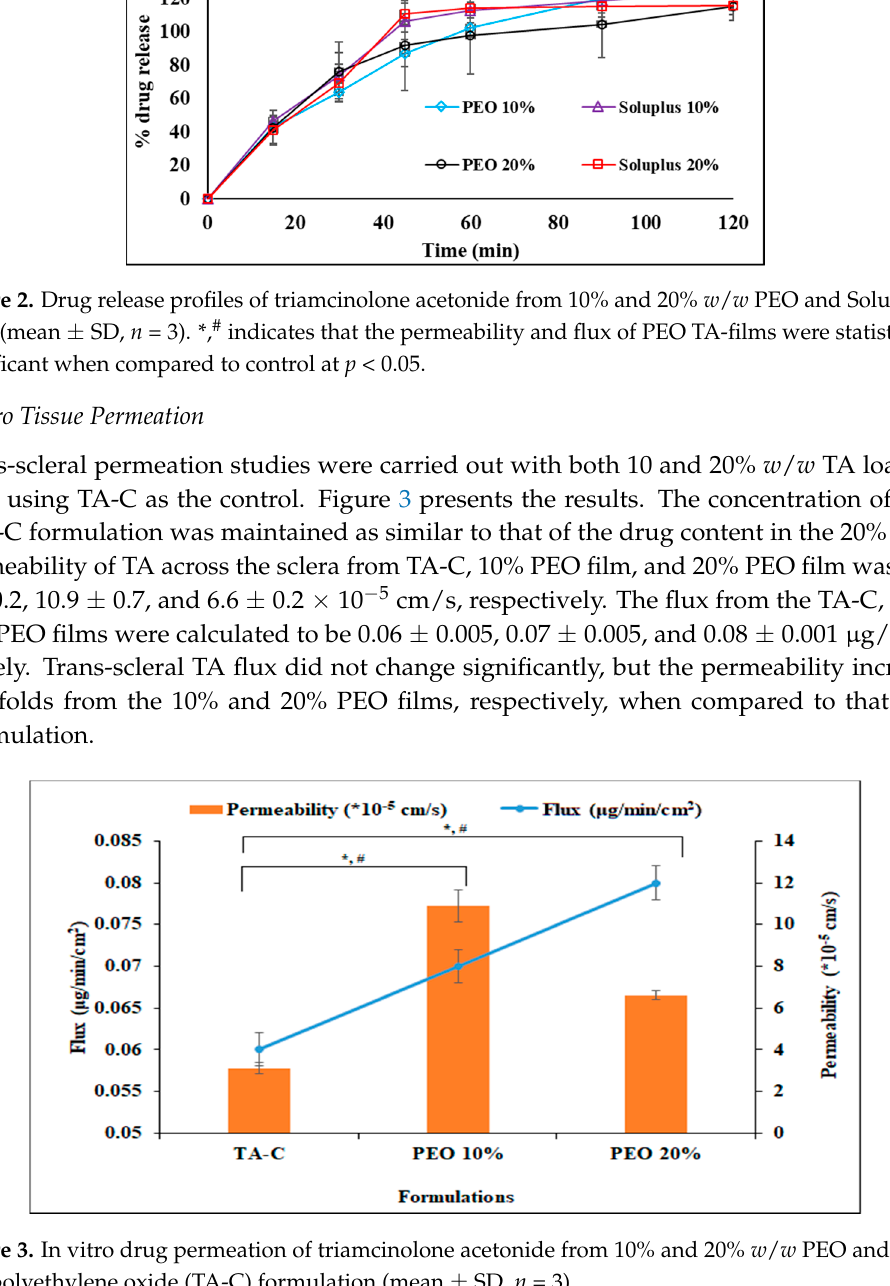
Figure 3. In vitro drug permeation of triamcinolone acetonide from 10% and 20% w / w PEO and films and polyethylene oxide (TA-C) formulation (mean ± SD, n = 3).